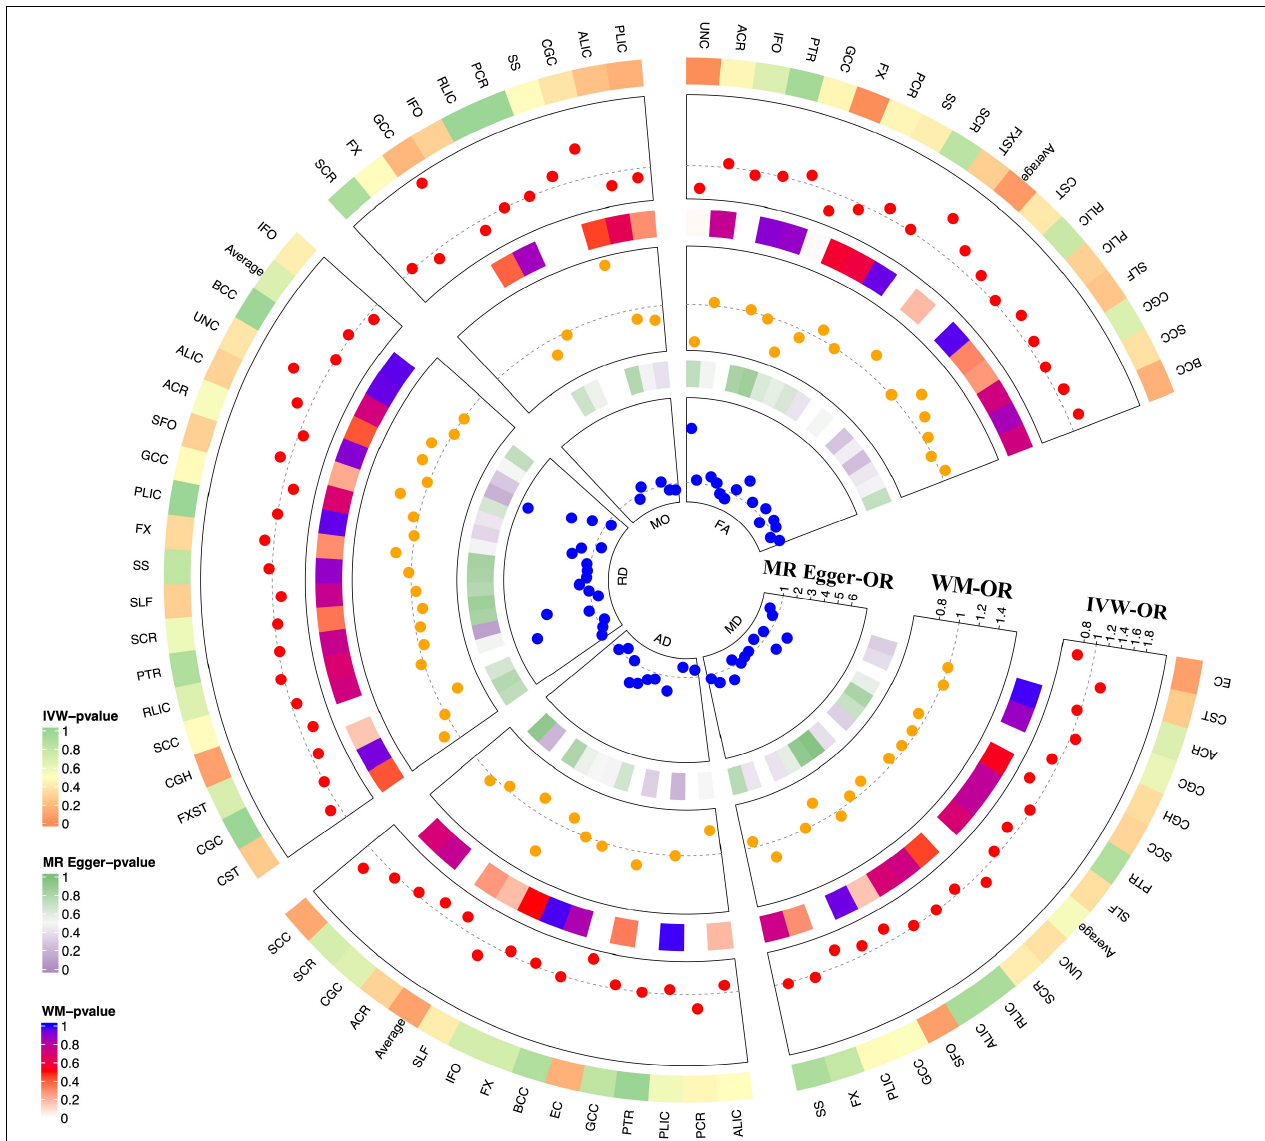
FIGURE 2 | MR results for DTI-Glaucoma associations. Each radius represents OR of one DTI measurement (red dot: MR-IVW; yellow dot: orange dot; blue dot: MR-Egger). From outer to inner layer: p -value for MR-IVW; OR for MR-IVW; p -value for MR-WM; OR for MR-WM; p -value for MR Egger; OR for MR-Egger. The dotted gray line indicated OR =